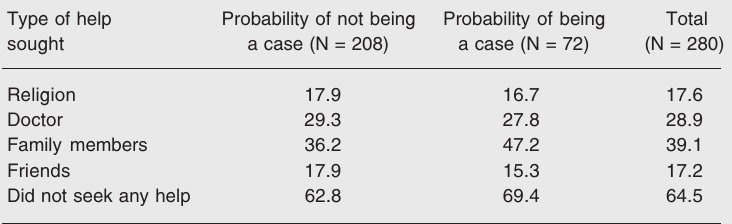
Table 2. Type of help sought by the patient for psychological